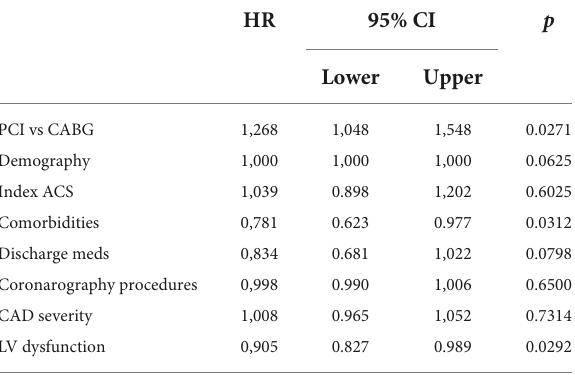
TABLE 4 Principal component (PC)-adjusted Cox regression for MACE as dependent